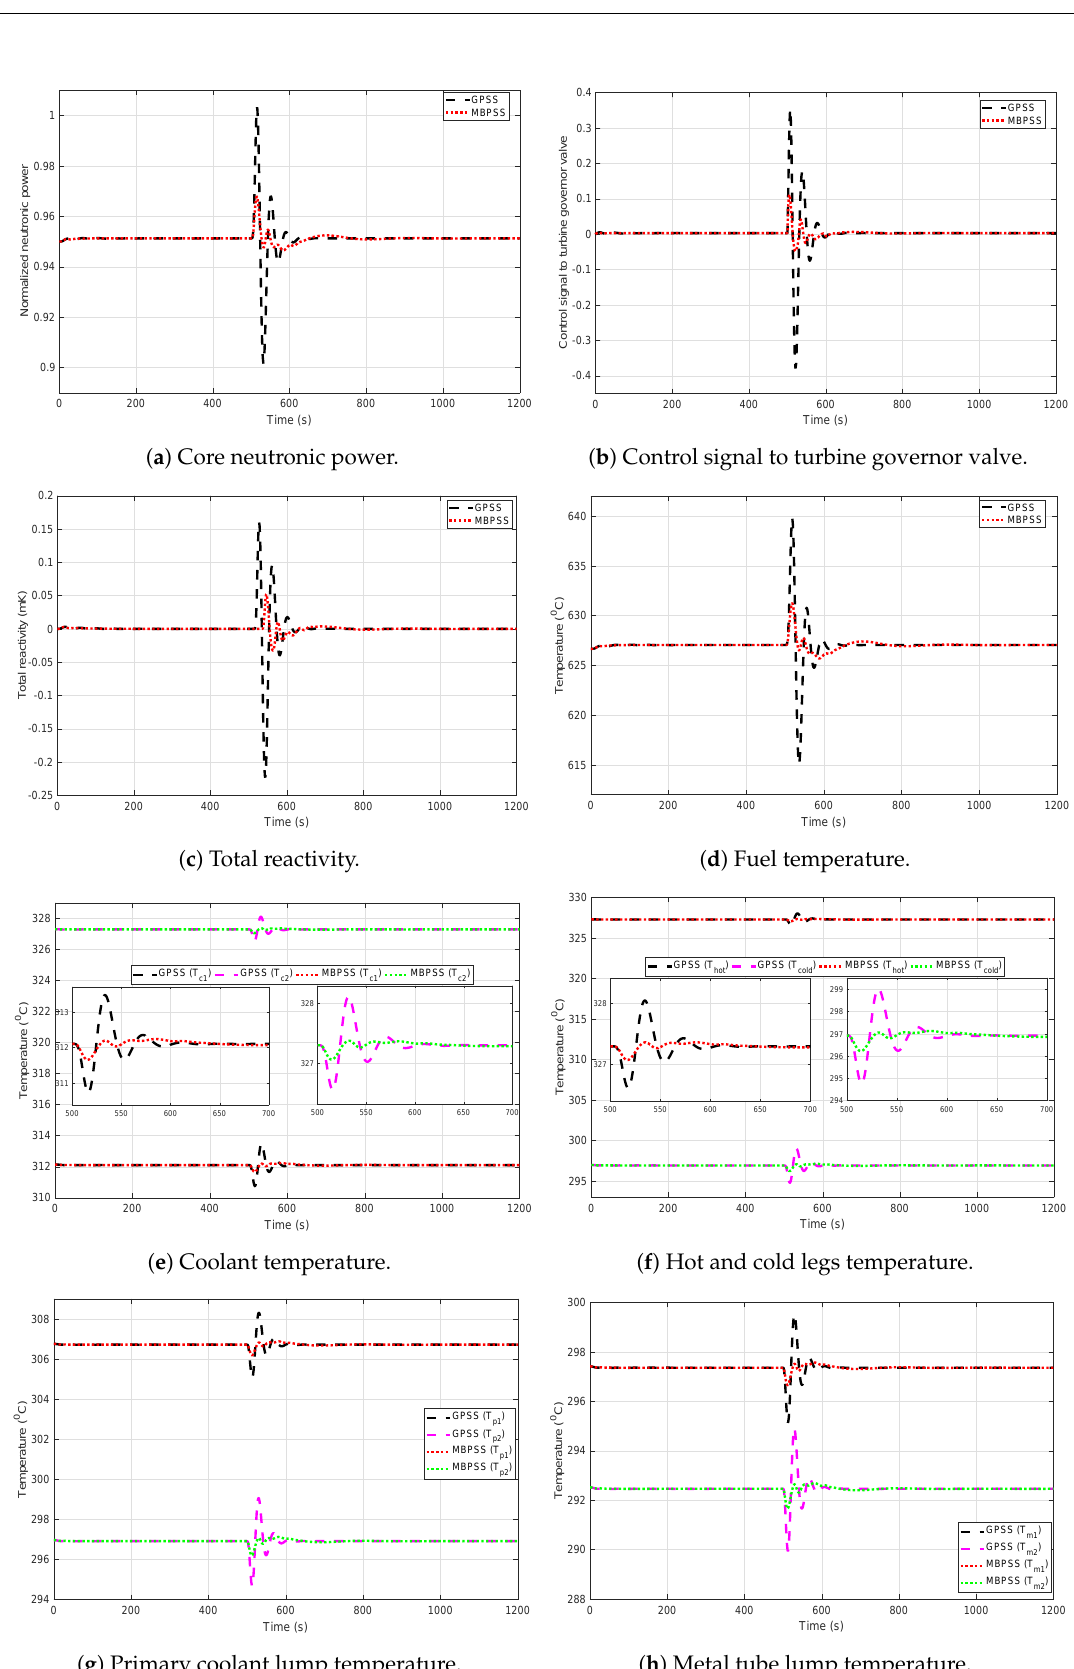
Figure 17. Case III.2: Variation in nuclear power plant variables during permanent load loss with generic and multiband PSS with